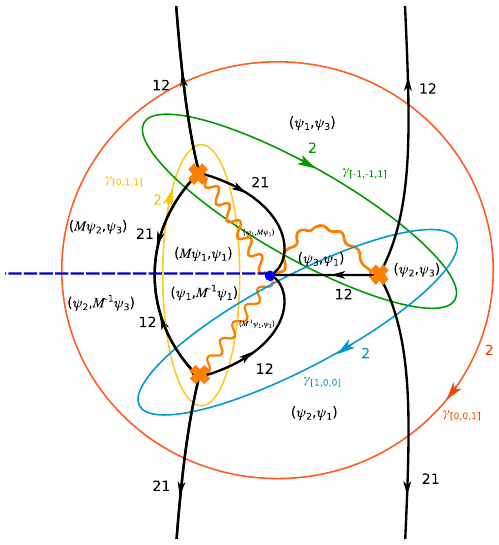
Figure 8 . W ϑ =0 for u = 0 , m = − 1 / 10 , Λ = 1 in the strong coupling region. Blue dotted line is the monodromy cut. The local basis of solutions for each domain is listed as ( ψ (1) , ψ (2) )